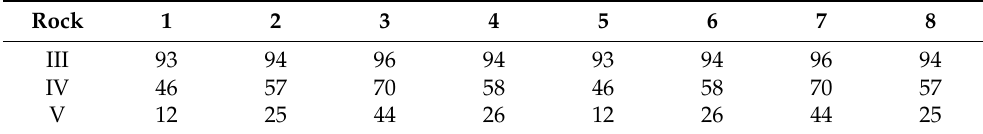
Table 2. Elastic load release coefficient of monitoring points around the tunnel